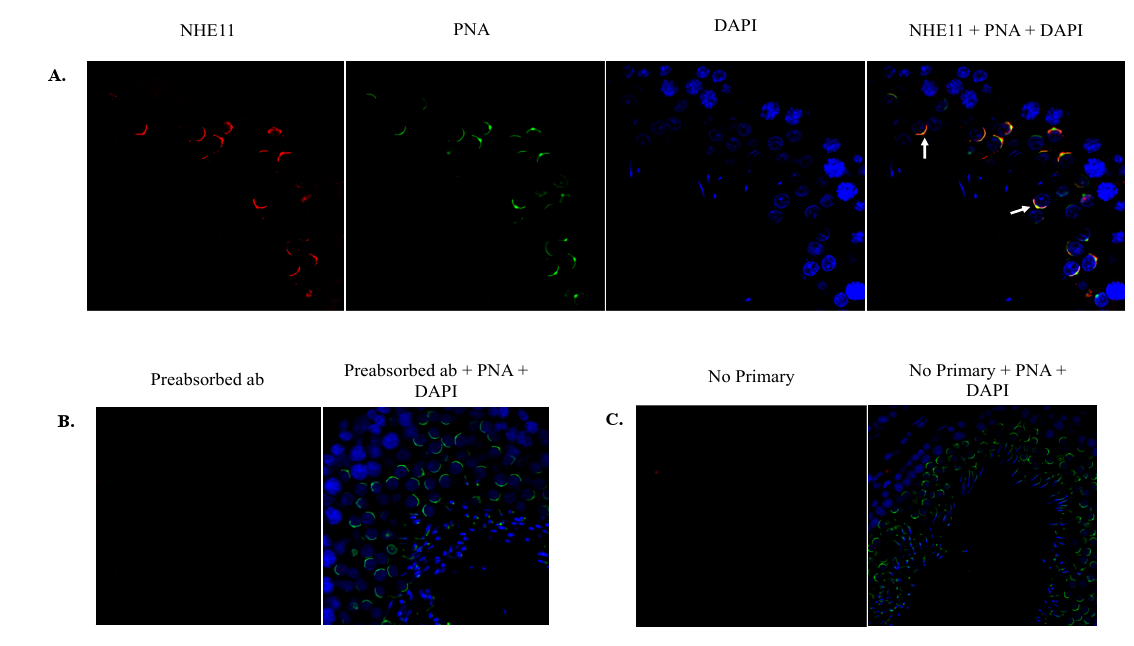
Figure 4. Immunohistochemical localization of NHE11 in rat testis sections. ( A ) Immunolocalization of NHE11 in rat testis sections using our anti-NHE11 antibody and a goat anti-rabbit Alexa 594 secondary antibody (red). PNA-FITC was used to stain the acrosome (green) and DAPI was used to counterstain the nuclei (blue). Note that NHE11 staining of the acrosome is observed in spermiogenic cells. Some spermiogenic cells seem to exhibit NHE11 and acrosomal co-localization (yellow), highlighted by arrows. For controls, ( B ) the anti-NHE11 antibody was preabsorbed with the antigenic NHE11 peptide and subsequently used for immunohistochemistry, or ( C ) the primary antibody was omitted entirely. Images were taken on a Zeiss LSM 710 confocal microscope with a 40× objective.